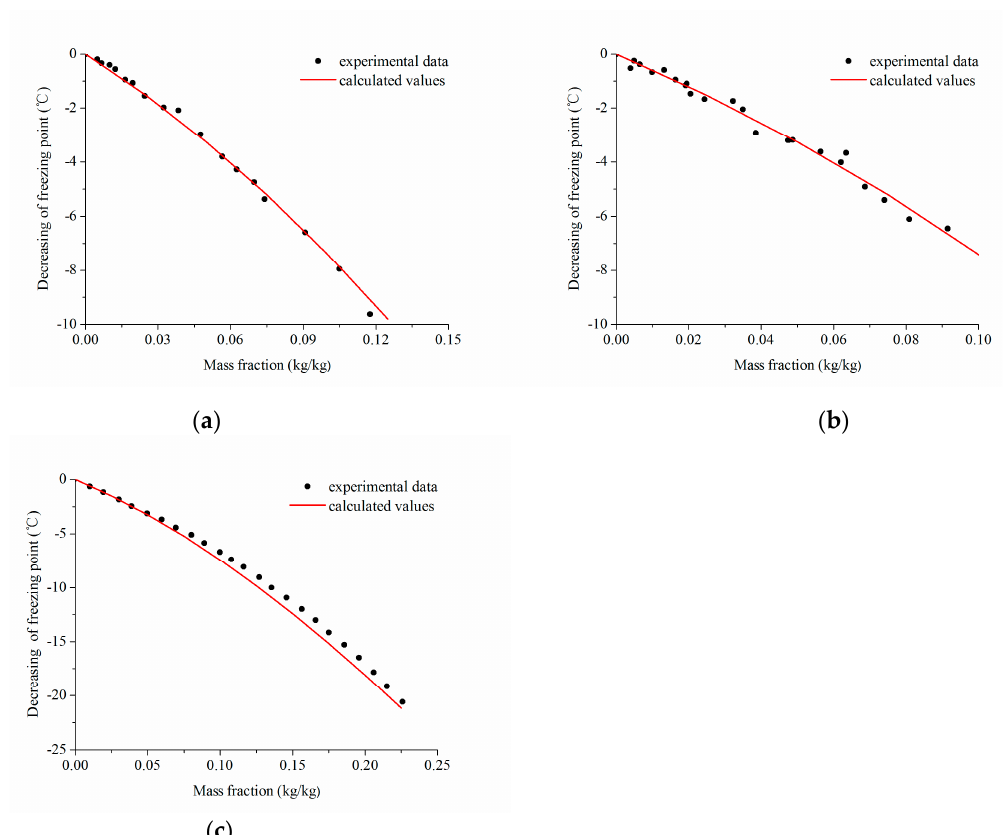
Figure 9. Comparison between the experimental data and the calculation value ( a ) Experimental data from this paper, ( b ) Experimental data from Bing and Ma (2011) [13], ( c ) Experimental data from Haynes et al. (2015) [18].